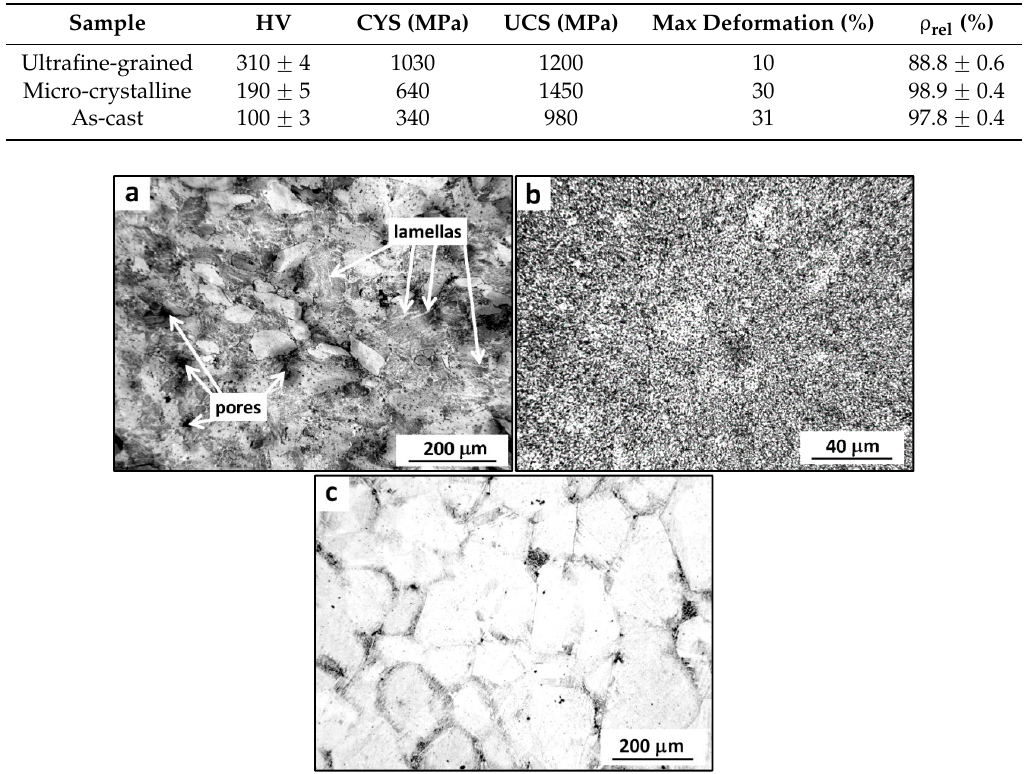
Figure 1. Microstructures of the bulk cobalt samples (OM): ( a ) ultrafine-grained cobalt prepared by ball milling and spark plasma sintering; ( b ) micro-crystalline cobalt prepared by spark plasma sintering; and ( c ) coarse-grained as-cast cobalt.